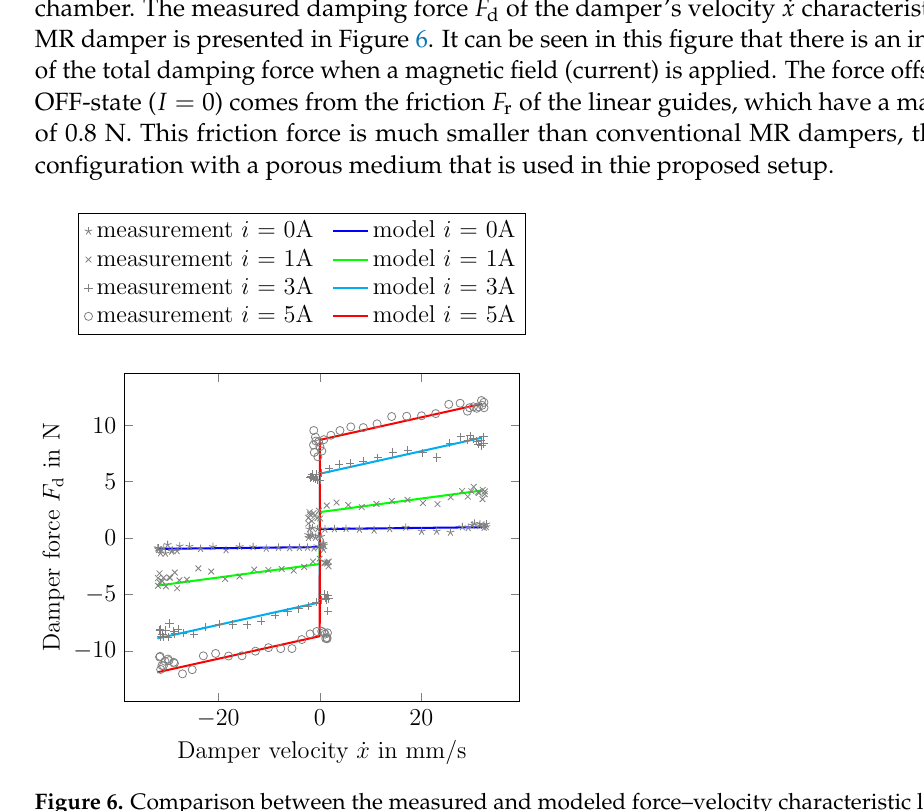
Figure 6. Comparison between the measured and modeled force–velocity characteristic line of the MR